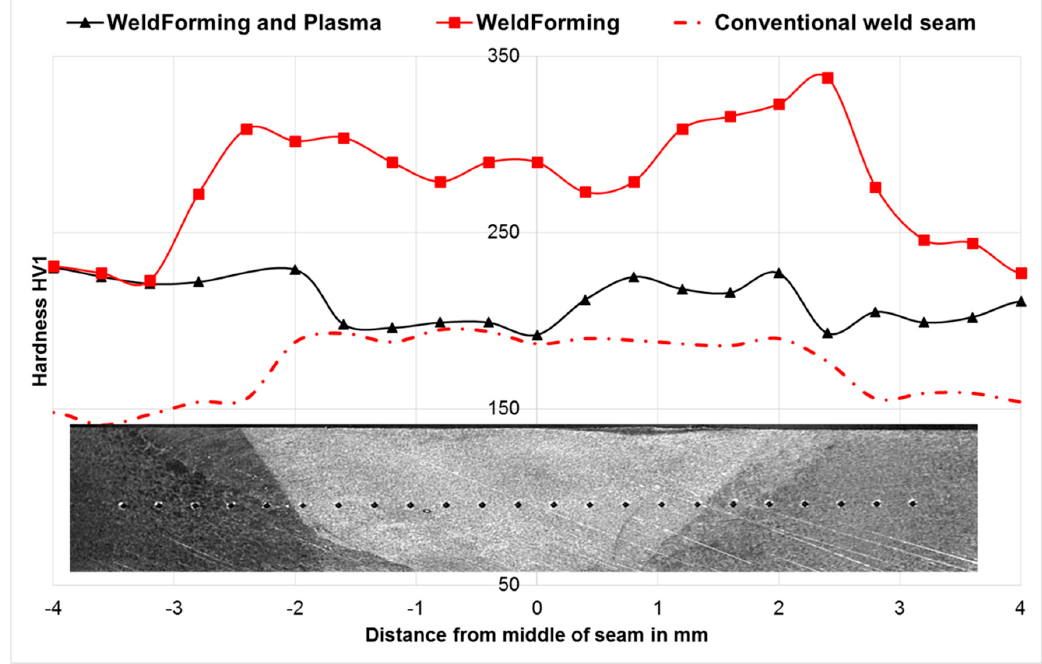
Figure 26. Hardness of weld seam and coarse grain zone for different welding methods.